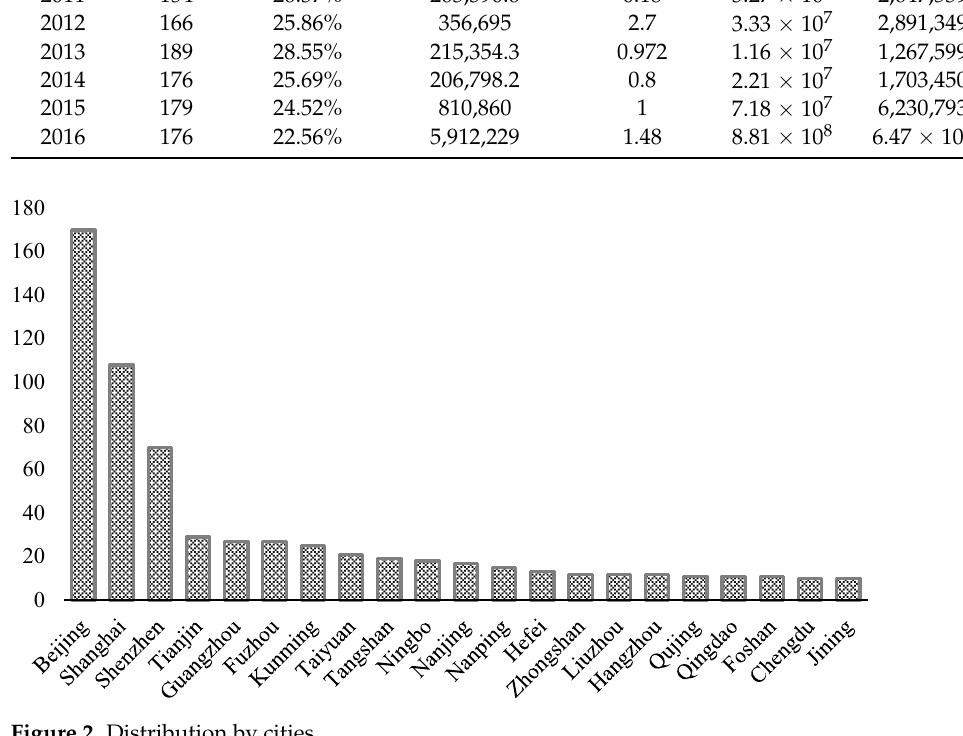
Figure 2. Distribution by cities.